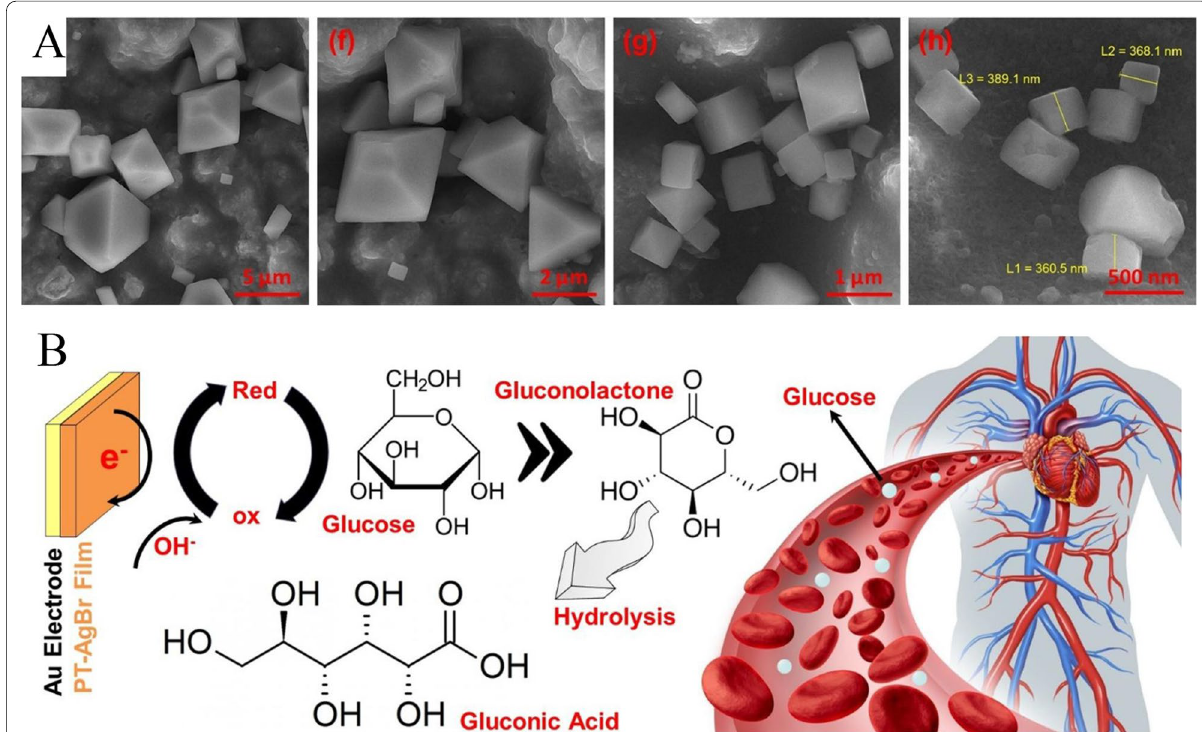
Fig. 15 A FESEM images of (e–h) PT-AgBr B Non-enzymatic biosensing mechanism of glucose via the developed platform within the human blood plasma. Adapted from Ref. [138] with permission. Copyright (2020) European Polymer